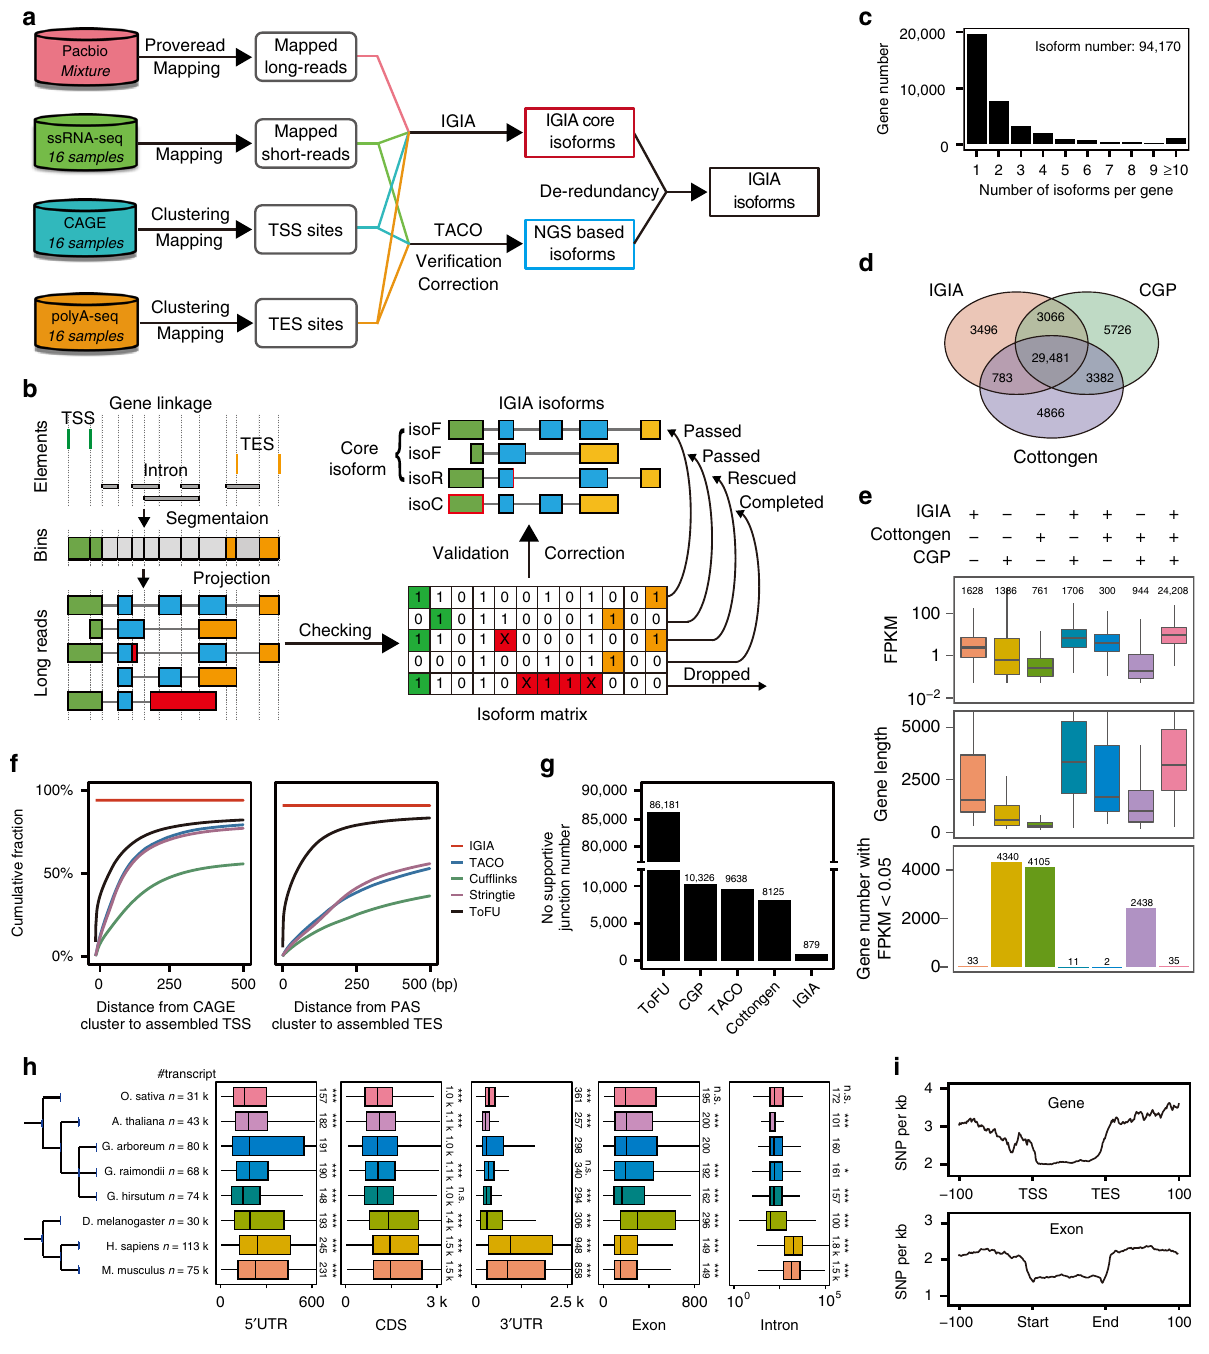
Fig. 1 Integrative multi-strategic RNA-seq for the high-resolution RNA landscape in G. arboreum . a Experimental design and analysis work fl ow for Integrative Gene Isoform Annotation (IGIA). b Schematic illustration of IGIA strategy for identifying accurate isoforms. See details in Methods section. c Distribution of the number of isoforms per gene. d Venn diagram of gene annotations comparisons between CGP, Cottongen and IGIA. e Distribution of FPKM, gene length, and number of lowly expressed genes in subgroups of genes. f The deviation between TSS (left, CAGE-seq) and TES (right, PolyA-seq) peaks compared with those assembled from IGIA and other methods. g The number of unique splicing junctions only supported by ToFU, CGP, TACO, Cottongen, and IGIA. h Length distribution of the 5 ′ UTR, CDS, 3 ′ UTR, exon, and intron, from IGIA annotation for cotton compared with seven other species. The median lengths and signi fi cances of difference were marked (* p -value < 0.05; ** p- value < 0.01; *** p -value < 0.001). i SNP distribution on composite gene body (top) and exon (bottom) of IGIA genes. The source data underlying Fig. 1e are provided as a Source Data fi that the transcripts from ToFU 27 annotations with Pacbio long Next, we assessed the annotated splicing junctions in this reads have higher resolution for 5 ′ and 3 ′ ends than TACO, study, by comparing with four sets of junction sites (JSs), StringTie and Cuf fl inks, indicating that short reads sequencing including predictions from ToFU, TACO, and the CGP and data alone are insuf fi cient for identifying accurate TSSs and TESs, Cottongen annotations (Supplementary Fig. 1d and Supplemen- especially TESs. tary Data 4, 5). Among the JSs, 99.3% (121,912/122,791) of IGIA